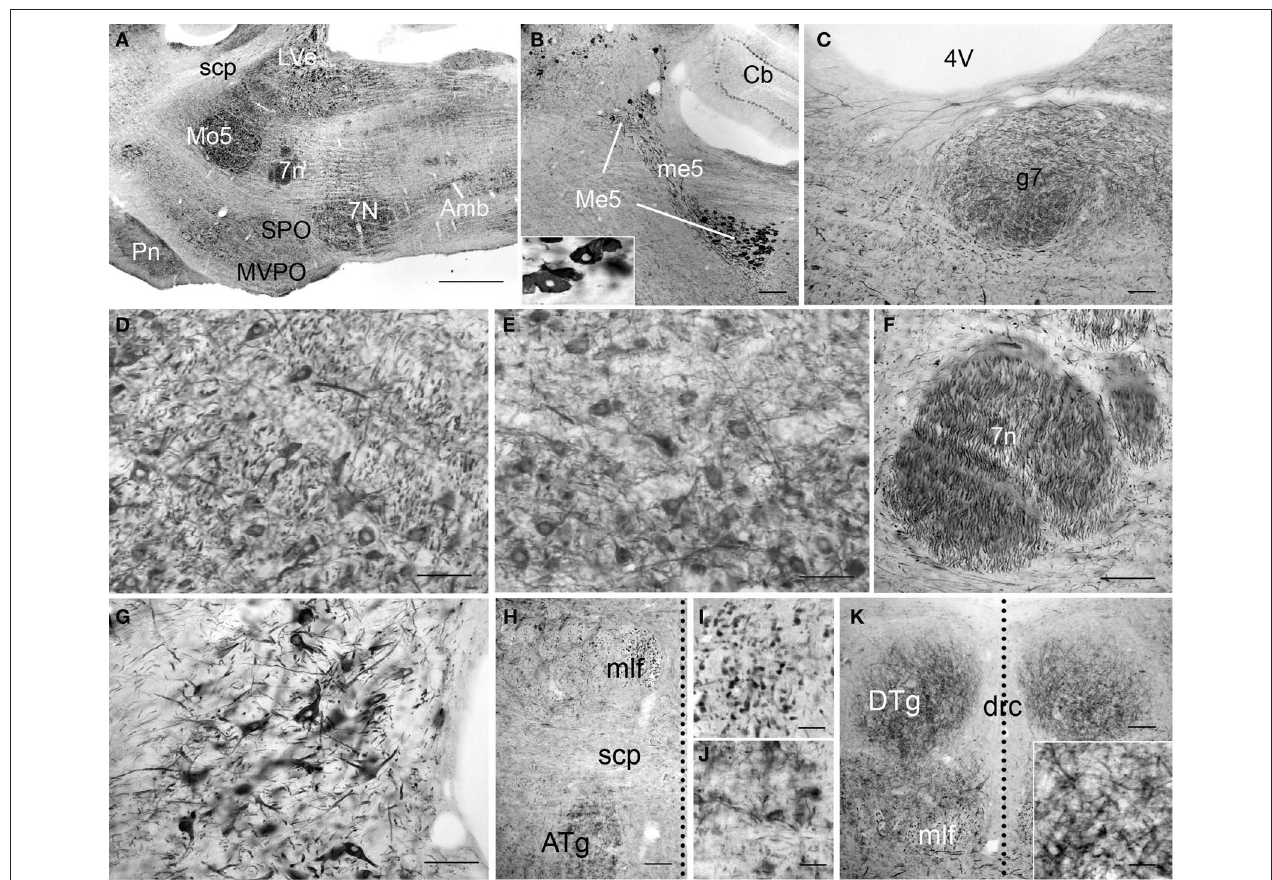
Figure 10 | PlexinA4 in the pons. Micrographs of sagittal (A–g) and coronal (H–K) sections through the adult rat pons immunostained for PlexinA4. PlexinA4 immunoreactive product is seen in neurons in the mesencephalic trigeminal nucleus (Me5; B ), the motor trigeminal nucleus (Mo5; A and D ), the facial nucleus (7N; A and e ), the lateral vestibular nucleus (LVe; A and g ), the anterior tegmental nucleus (ATg; H and J ) and the dorsal tegmental nucleus (DTg; K ). Insert in (B) shows a higher magnification view of PlexinA4 positive cell bodies in the Me5. Immunoreactive fibers were visible in the genu of the facial nerve (g7; C ), the facial nerve (7n; A and F ) and the medial longitudinal fasciculus (mlf;